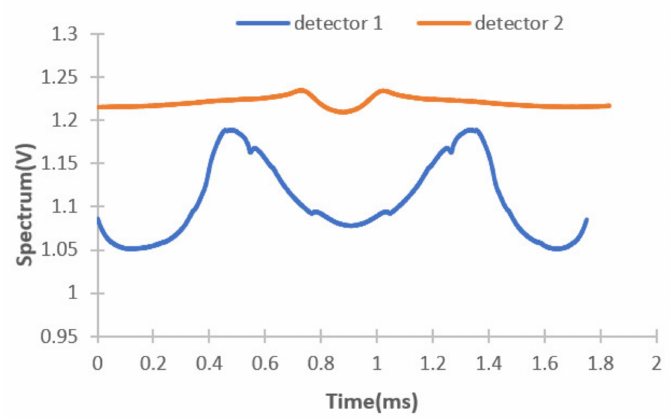
Figure 22. Driving signal and output signal of the MOEMS mirror. The spectrum response curves of detectors 1 and 2 are shown in Figure 23.